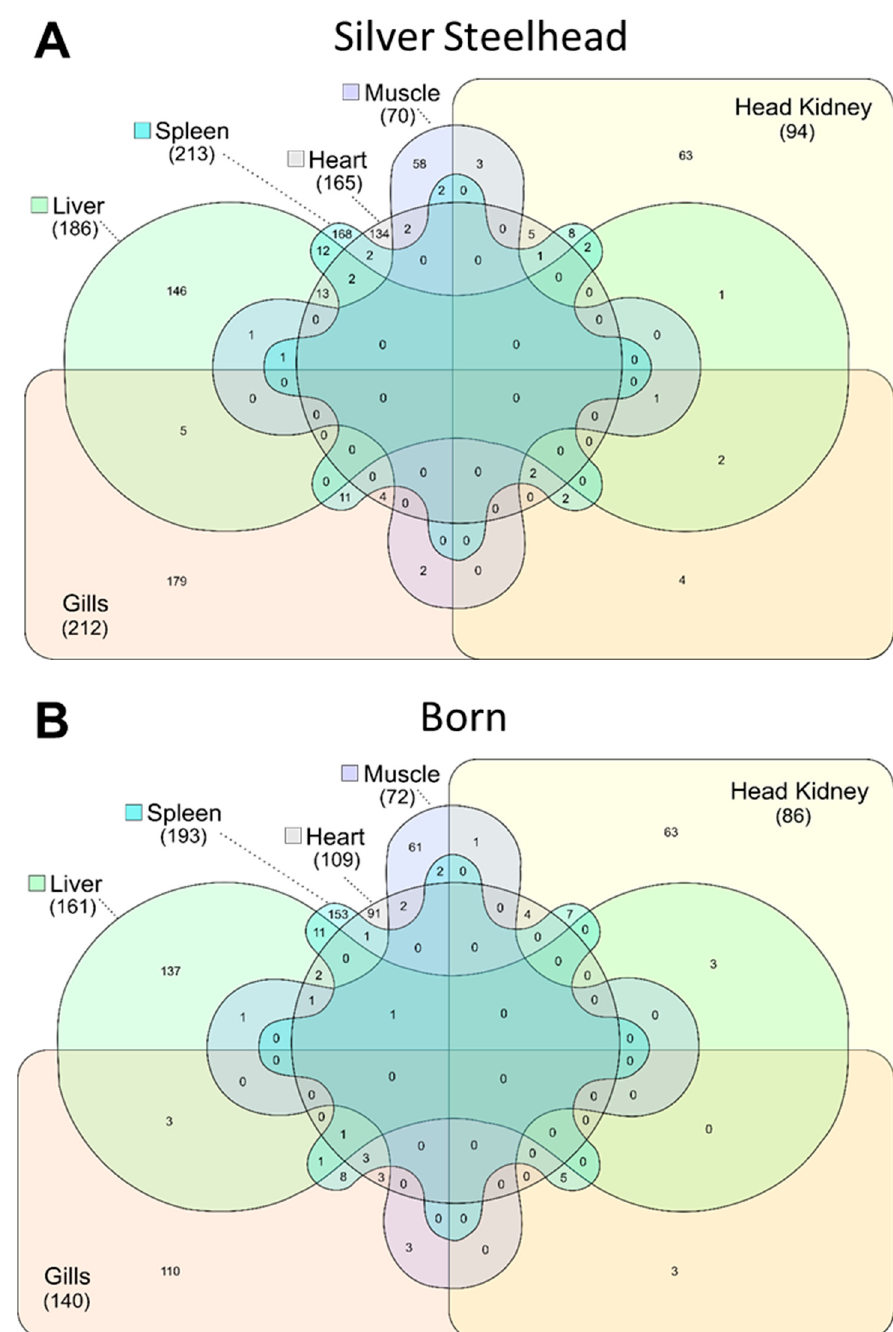
Figure 1. Venn diagram illustrating the common and exclusively expressed genes in the gills, head kidney, heart, liver, spleen, and the white muscle of rainbow trout strain ( A ) Silver Steelhead compared to strain Born, and ( B ) Born compared to strain Silver Steelhead. The total number of differentially expressed genes for each tissue is given in brackets.